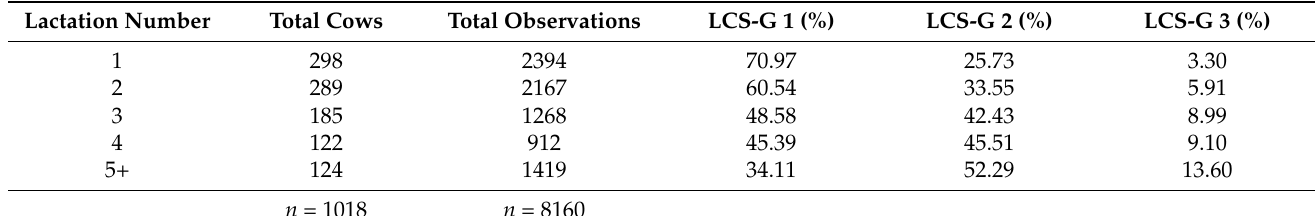
Table 4. Lameness incidence risk according to lactation number; LCS-G 1–3: locomotion score groups 1 to 3.